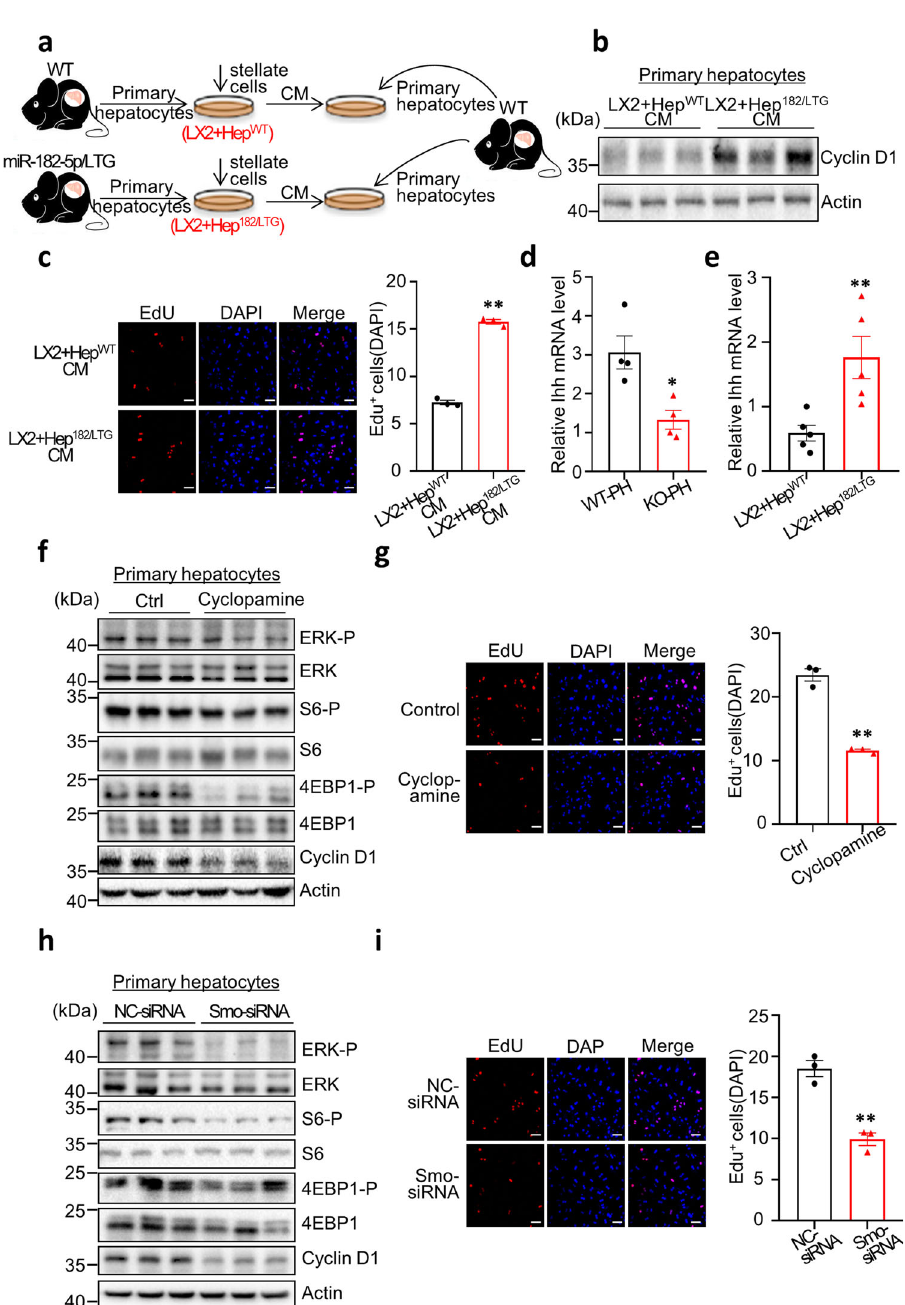
Fig. 5 miR-182-5p promotes hepatocyte proliferation by stellate cell-dependent activation of hedgehog signaling. a A schematic diagram of the co- culture experiment in which primary hepatocytes were treated with a conditioned medium (CM) of HSCs (LX2 cells) co-cultured with miR-182-5p- overexpressed hepatocyte (LX2 + Hep 182/LTG ) or with that of their control (LX2 + Hep WT ) for 24 h. b Western blot analysis of Cyclin D1 level in primary hepatocytes. c EdU immunostaining of primary hepatocytes ( n = 3/group; scale bar: 100 μ m). d qRT-PCR analyses of Ihh gene expression in the liver of miR-182-5p KO and WT mice (3d after PH; n = 4/group). e qRT-PCR analyses of Ihh gene expression in LX2 co-cultured with primary hepatocytes from miR-182-5p TG mice (LX2 + Hep 182/LTG ) or their control mice (LX2 + Hep WT )( n = 4/group). Primary hepatocytes were treated with a conditioned medium of stellate cells co-cultured with miR-182-5p-overexpressed hepatocyte treated with or without cyclopamine. f Western blot analysis of proliferative signaling in primary hepatocytes. g EdU immunostaining of primary hepatocytes ( n = 3/group; scale bar: 100 μ m). Smo siRNA or control siRNA (NC-siRNA)-treated primary hepatocytes were treated with a conditioned medium of stellate cells co-cultured with miR-182-5p-overexpressed hepatocytes. h Western blot analysis of proliferative signaling in primary hepatocytes. i EdU immunostaining of primary hepatocytes( n = 3/group; scale bar: 100 μ m). Error bars in all experiments represent SEM; Signi fi cance was determined by unpaired two-tailed Student ’ s t test. * P < 0.05, ** P < 0.01. COMMUNICATIONS BIOLOGY| (2022) 5:771